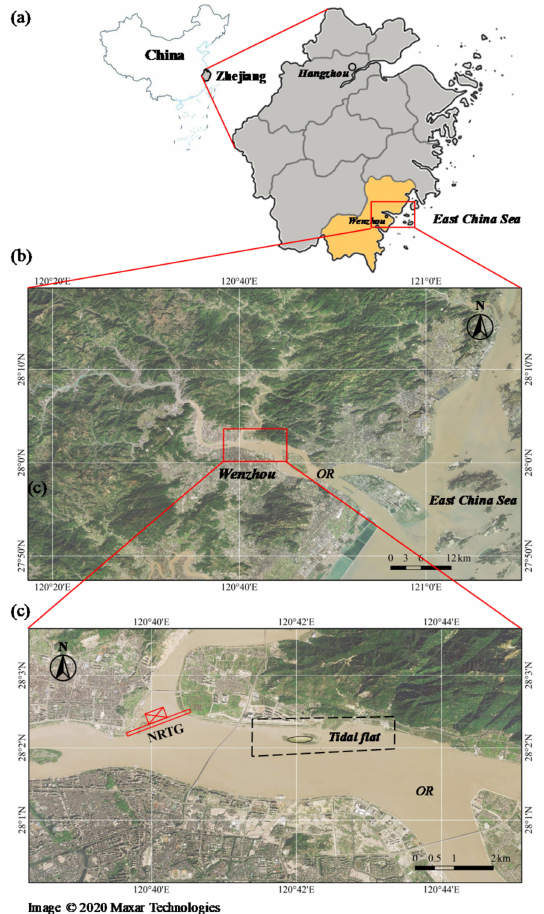
Figure 1. Study area: ( a ) Zhejiang Province in China, ( b ) the Ou River (OR) estuary, and ( c ) the Nanxi River tidal gate (NRTG) on the mouth of the Nanxi River (NR). A dashed box in Figure 1c marks the observed intertidal flat in the model